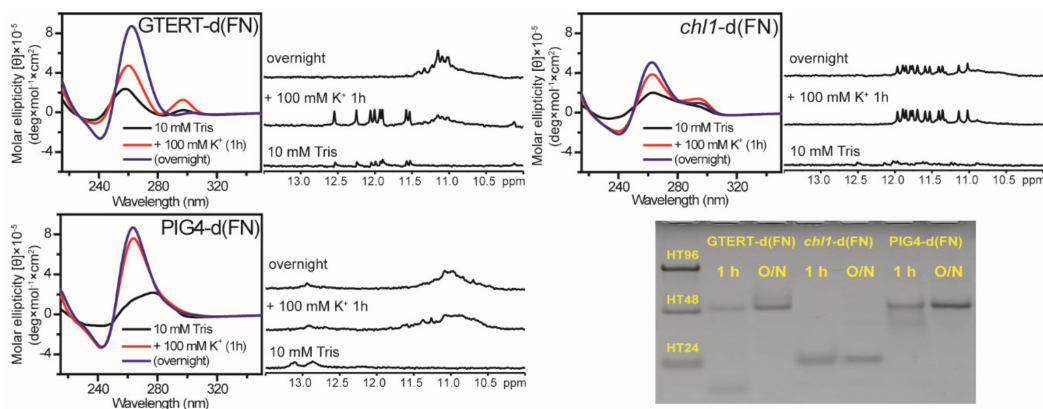
Figure 6. The E ff ect on G4 formation of native G-rich sequences without flanking nucleotides. CD and NMR spectra of GTERT-d(FN), PIG4-d(FN), and chl1 -d(FN) in 10 mM Tris and after 1 h and overnight (O / N) addition of 100 mM K + together with their PAGE assays of marker bands of HT24 (T 2 AG 3 ) 4 , HT48 (T 2 AG 3 ) 8 , and HT96 (T 2 AG 3 ) 16 and each sequence after 1 h and O / N addition of 100 mM K + for GTERT-d(FN), chl1 -d(FN), and PIG4-d(FN). The same DNA concentration of 100 µ M was used in the experiments of CD, NMR and PAGE of this